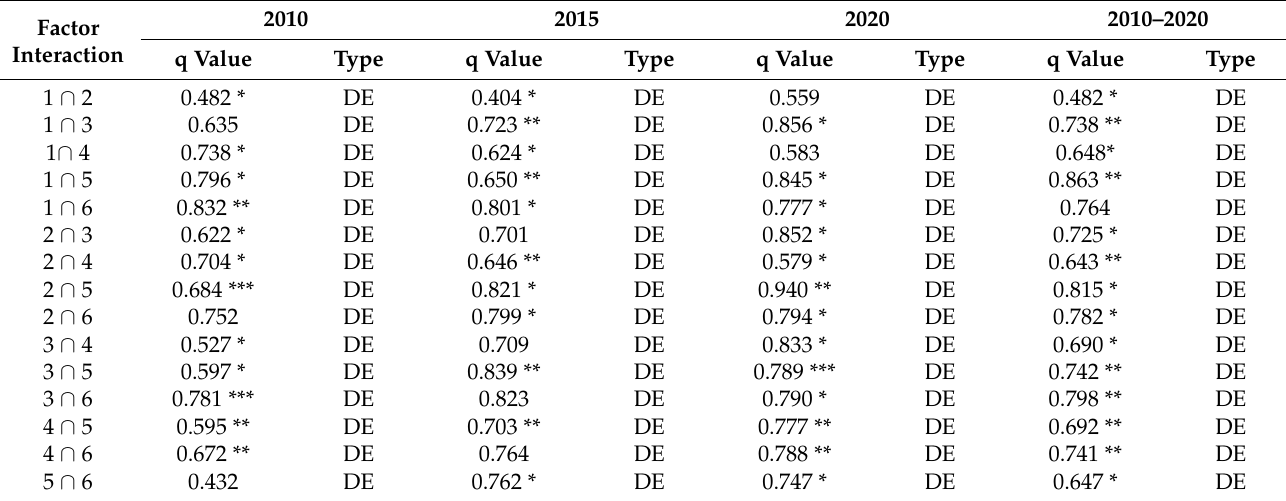
Table 7. Interaction detection results of influencing factors of